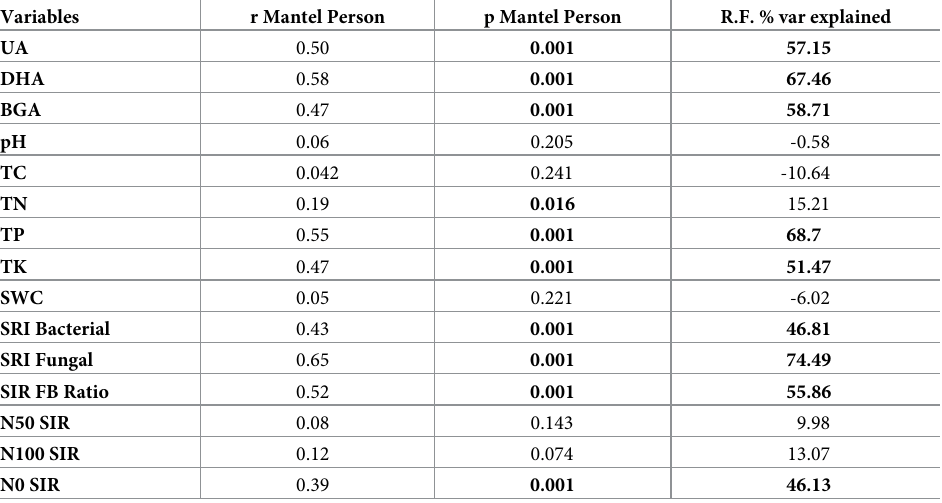
Mantel correlations are based on Person correlation coefficients. These were also determined based on Spearman correlation, which yielded comparable results. P values < 0.05 and variables with higher than 30% variance explained by the OTU table are in bold